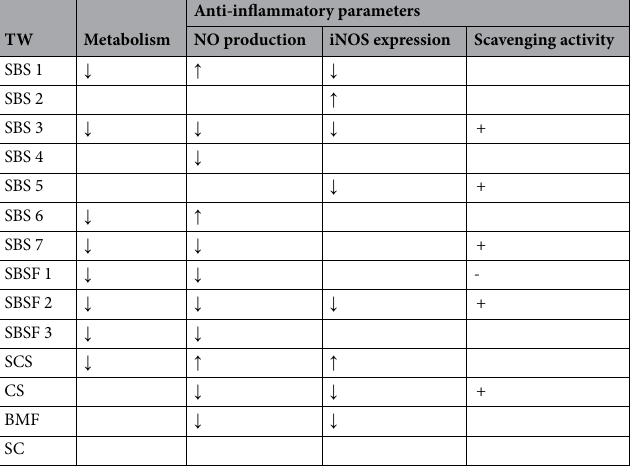
Table 4. Results summary. ( ↓ ) = decrease and ( ↑ ) = increase of the evaluated parameters. + = positive activity;—= negative activity; the blank rectangles indicate the lack of statistically significant